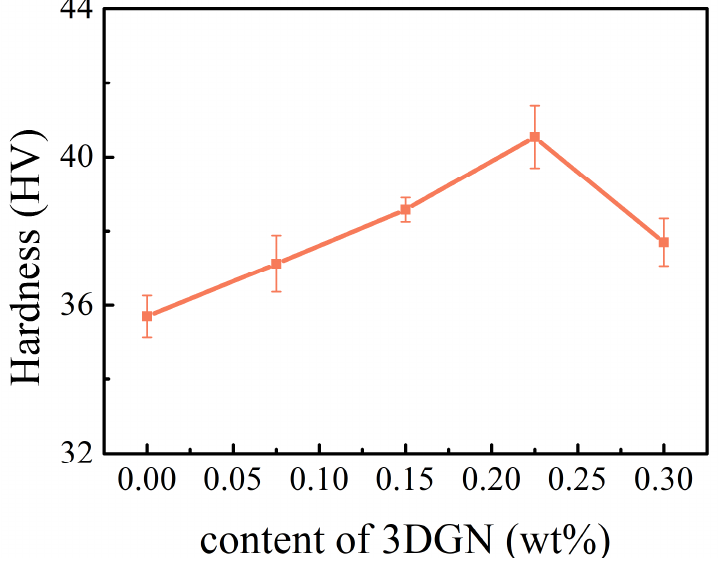
Figure 7. Vickers hardness of the bulk 3DGN/Al composites with different 3DGN contents.